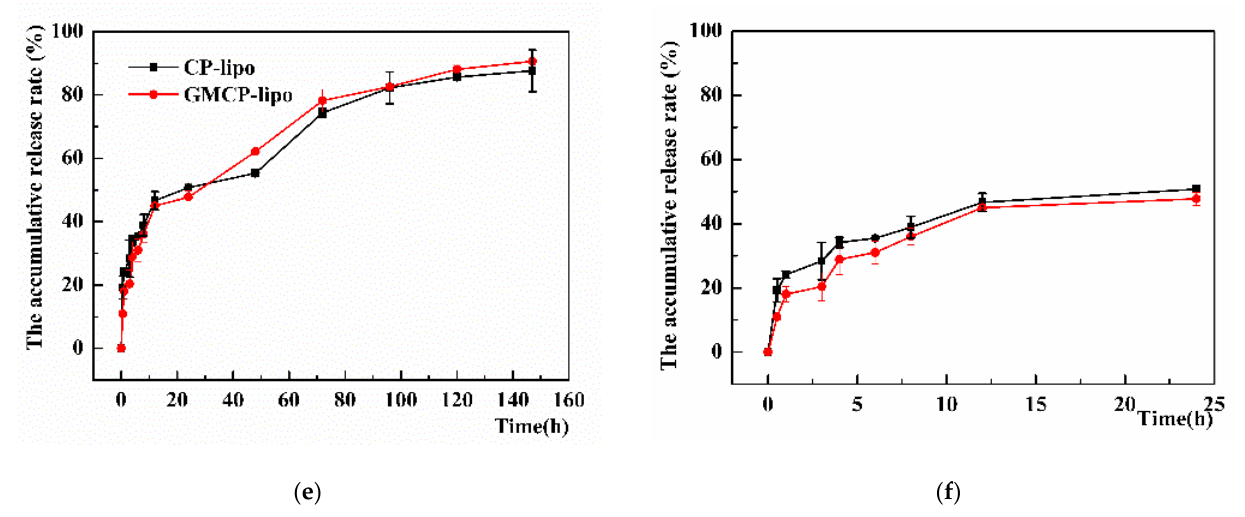
Figure 4. The particle size change of CP-liposome ( a ) and GMCP-liposome ( b ) in various physical media at 37 °C, and the XRD ( c ) and DSC ( d ) pattern of lyophilized CP-liposome and GMCP-liposome in contrast to free CBD, free PPD, SPC, Mal, and the corresponding physical mixture. The accumulative in vitro CBD release from CP-liposomes and GMCP liposomes within 144 h ( e ) or within 24 h ( f ).